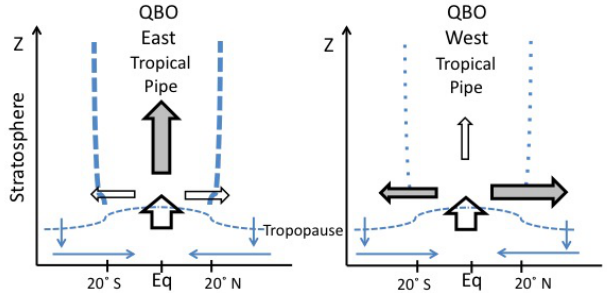
Fig. 13. Interpretation of the QBO influence on the BDC variability. During the QBO easterly phase (left) the tropical pipe is stronger and it takes more time for air masses to cross the barrier towards mid-latitudes. Thus the meridional speed is slower. For continuity, the vertical branch has to speed up which is shown by the big shaded vertical arrow. On the other hand during the QBO westerly phase the tropical pipe is shifted up, more leaky and transport towards the mid-latitudes faster (right). Again, for continuity reasons, the vertical transport has to slow down which agrees well with our results.